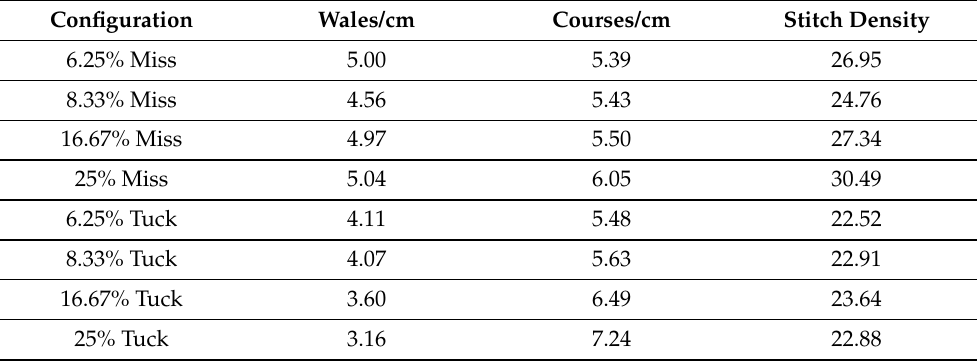
Figure 7. Knitted samples with miss stitches. ( a ) 6.25% miss stitches ( b ) 8.33% miss stitches ( c ) 16.67% miss stitches ( d ) 25% miss stitches. Table 3. Fabric parameters of the knitted